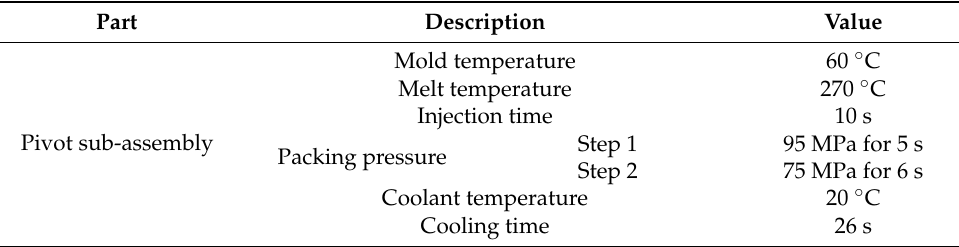
Table 6. Process conditions of pivot sub-assembly and open lever nominal dimensions in existing mass